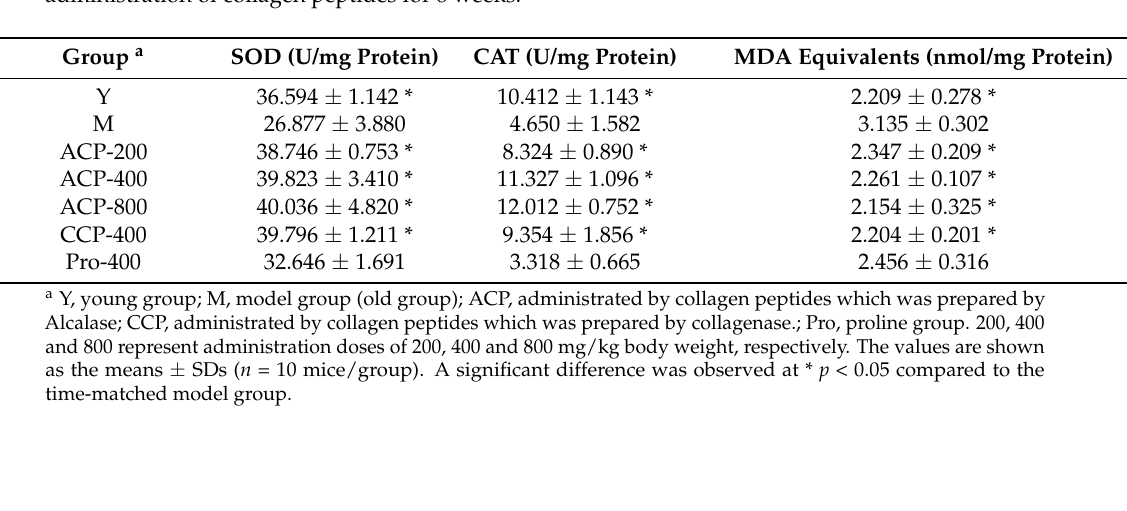
Table 4. SOD and CAT activities and MDA content in dorsal skin of chronologically aged mice after administration of collagen peptides for 8 weeks.